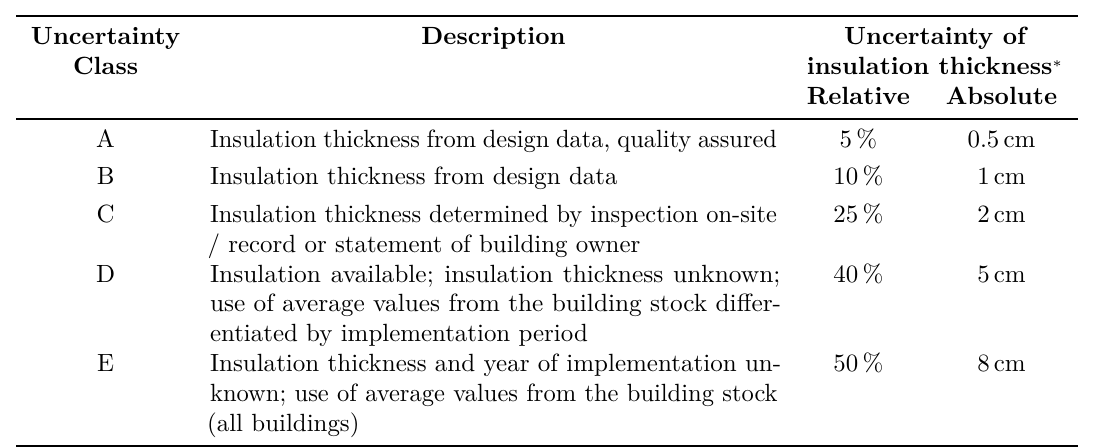
Table 2. Example of uncertainty classification for an input variable (insulation